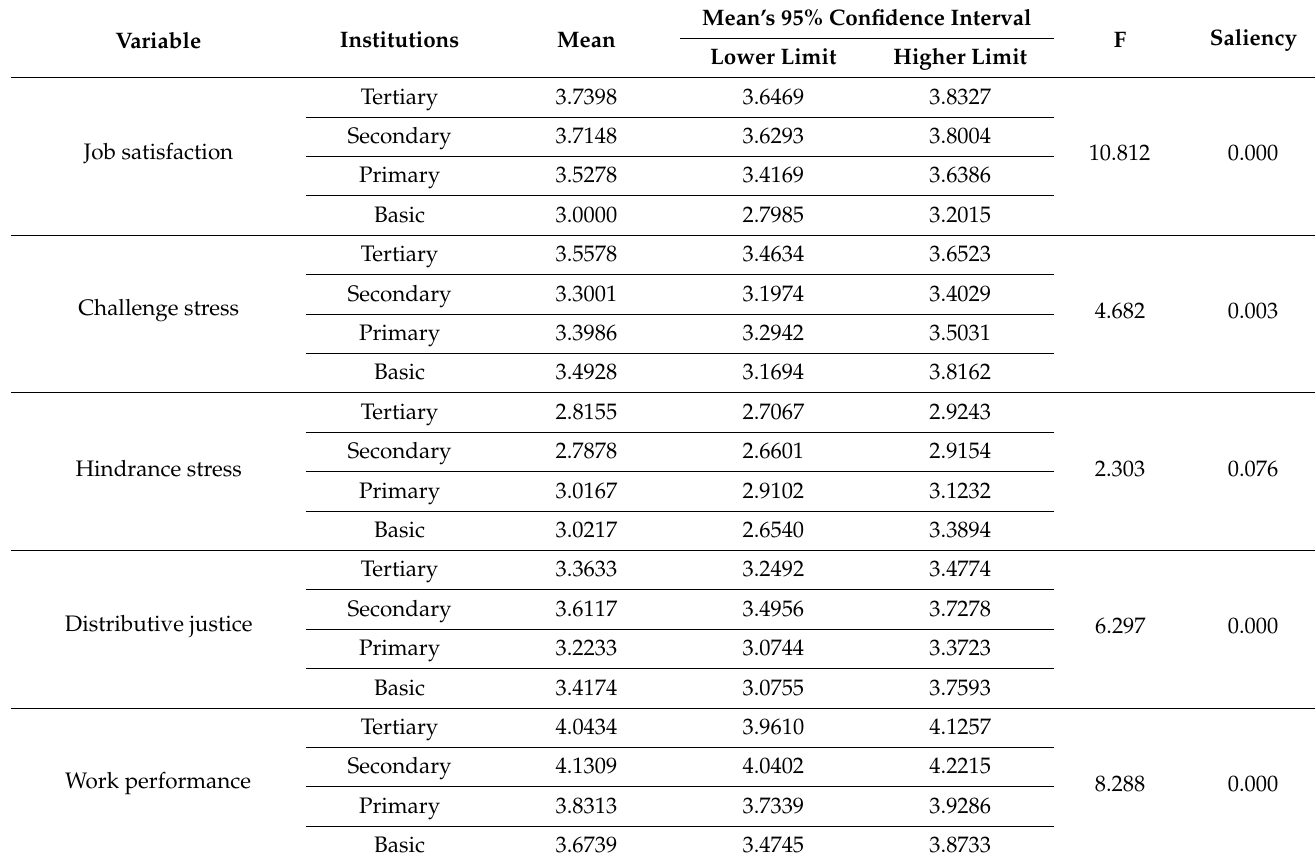
Table 5. Subjective perception ANOVA test of healthcare workers of hospitals at all levels and basic healthcare